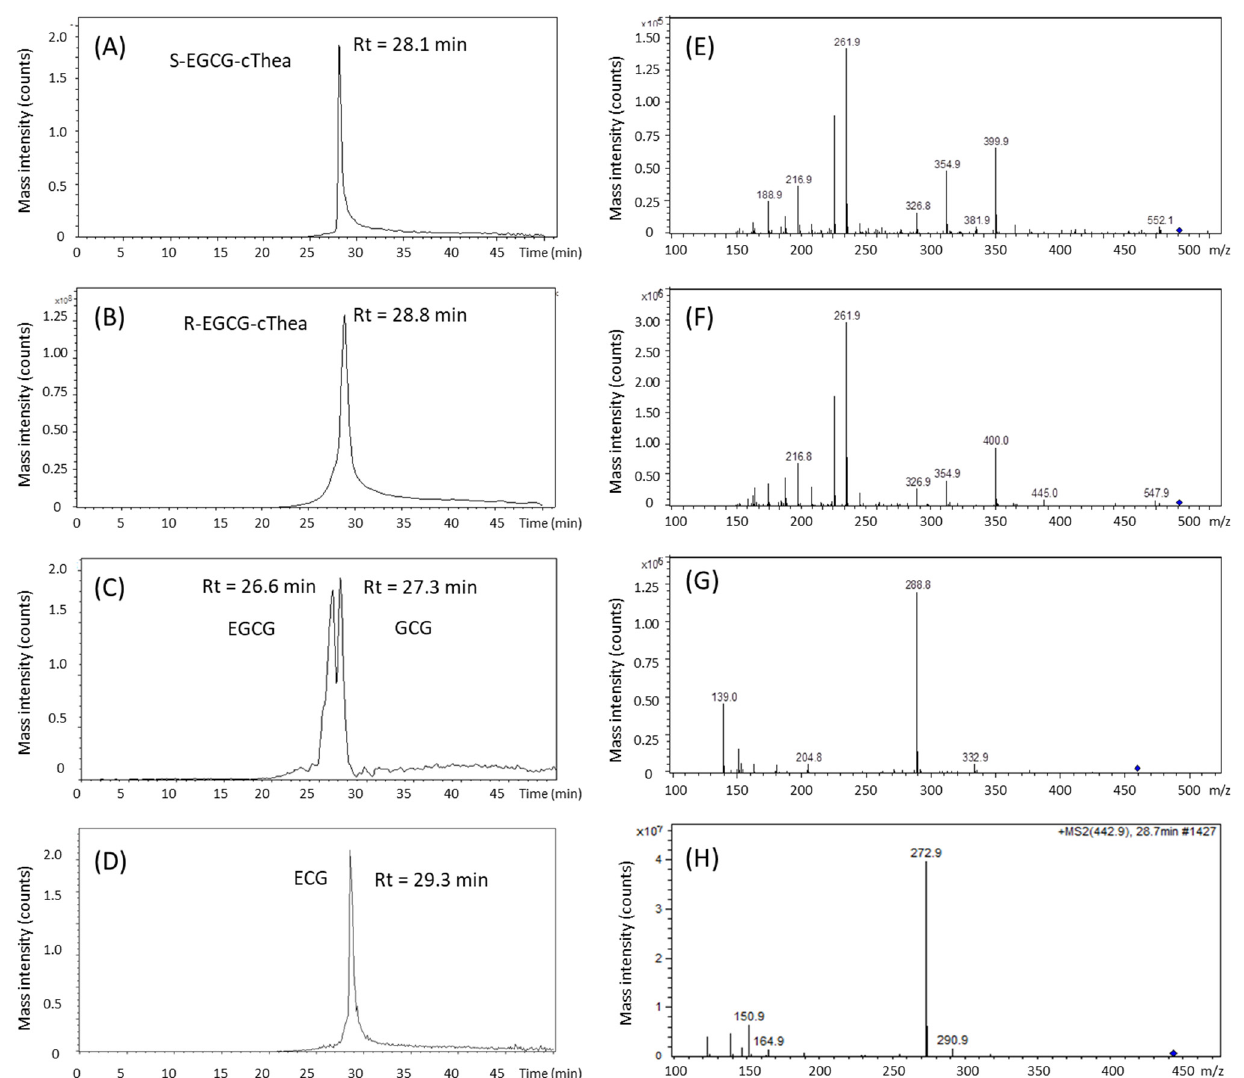
Figure 2. LC-ESI-MS selected ion chromatogram with [M + H] + -signals of ( A ) S -EGCG-cThea ( m/z 570), ( B ) R -EGCG-cThea ( m/z 570), ( C ) EGCG and GCG ( m/z 459), and ( D ) ECG, and ESI-MS 2 fragment ions of ( E ) S -EGCG-cThea ( m/z 570), ( F ) R - EGCG-cThea ( m/z 570), ( G ) EGCG and GCG ( m/z 459), and ( H ) ECG ( m/z 443).